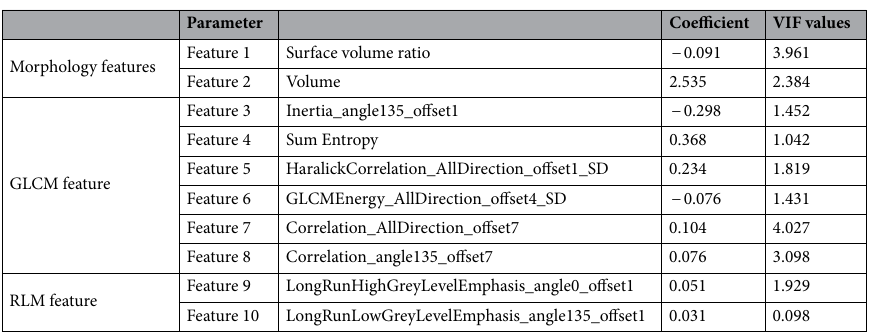
Table 2. Texture parameters after the dimensionality